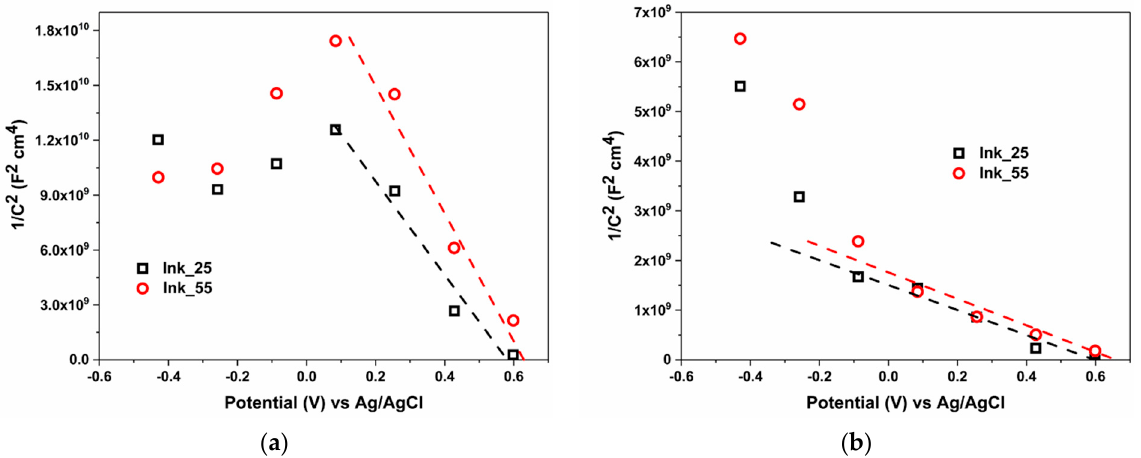
Figure 9. Mott–Schottky plots of Cu 2 O-based ( a ) and Cu 2 O/CuO-based ( b ) films. A negative slope was obtained for each Mott–Schottky plot indicating that these materials are p-type semiconductors and thus suitable as cathodes for the water-splitting reaction. This is due to their ability to use the photogenerated electrons to drive the reduction of water to hydrogen. From the Mott–Schottky equation and considering the slope of the linear part of the curves reported in Figure 9 and the intercept on the x axes (at 1/C 2 equal to 0), the majority carrier density ( N A ) and flat-band potential ( E fb ) were estimated. The corresponding values are reported in Table 3 where the flat-band potential is also converted into reference potential scale NHE. The highest N A was obtained for the Cu 2 O/CuO films, indicating a fast charge transfer from the photoelectrode surface to the electrolyte, and slow charge recombination mechanisms [23,31]. Moreover, higher flat-band potential values were obtained for the films based on Cu 2 O/CuO, indicating (for a p-type semiconductor) a higher degree of band bending; this induces a large driving force to separate the photoinduced charges in the space charge region [31,32]. Both higher number of donors and flat-band potential contribute to enhance the photocurrent and PEC performances. For p-type semiconductor, the E fb values could be taken as a reasonable approximation ( ≤ 100 mV) to the valence band position (VB), while the conduction band position (CB) can be evaluated adding to the VB the E g value previously calculated (Table 3). The obtained CB positions are equal to − 0.53 V and − 0.47 V vs. NHE for Cu 2 O-based films on ink_25 and ink_55 respectively, and − 0.31 V and − 0.24 V vs. NHE for Cu 2 O/CuO- based films on ink_25 and ink_55 respectively. These CB edges are more negative than the redox potential of the H 2 O/H 2 reaction at the same pH environment for all the films tested, indicating that the photoinduced electrons in the conduction band can be efficiently injected into the electrolyte for the reduction of water. Linear scan voltammetry (LSV) in light/dark conditions was used to quantify the photocurrent produced by each film (Figure 10). High electrical conductivity was observed for each electrode in the wide potential range tested up to − 1.0 V vs. Ag/AgCl. Considering the photoelectrodes based on Cu 2 O, the photocurrents acquired are 0.026 mA cm − 2 , 0.058 mA cm − 2 for ink_25 and ink_55 respectively. The films based on a mixed Cu 2 O/CuO were able to produce 0.040 mA cm − 2 and 0.089 mA cm − 2 (ink_25 and ink_55, respectively). The highest photocurrent densities were obtained (considering the same ink composition) for the films based on Cu 2 O/CuO, due to the highest quantity of carriers available and the low amount of recombination phenomena that occurs at the photoelectrode surface. However, the higher porosity of the ink_55 films (in respect to the Ink_25 ones) enhances the electron transfer from the electrode surface to the electrolyte increasing the photocurrent values.